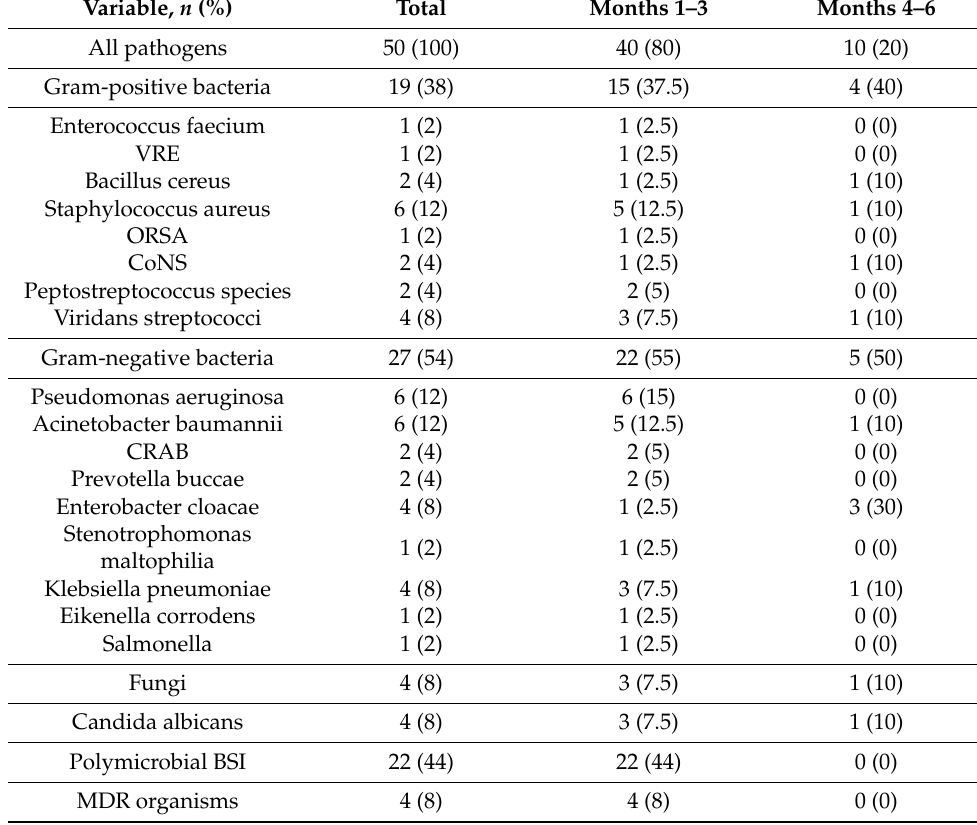
Table 2. Distribution of pathogens isolated from blood bacterial